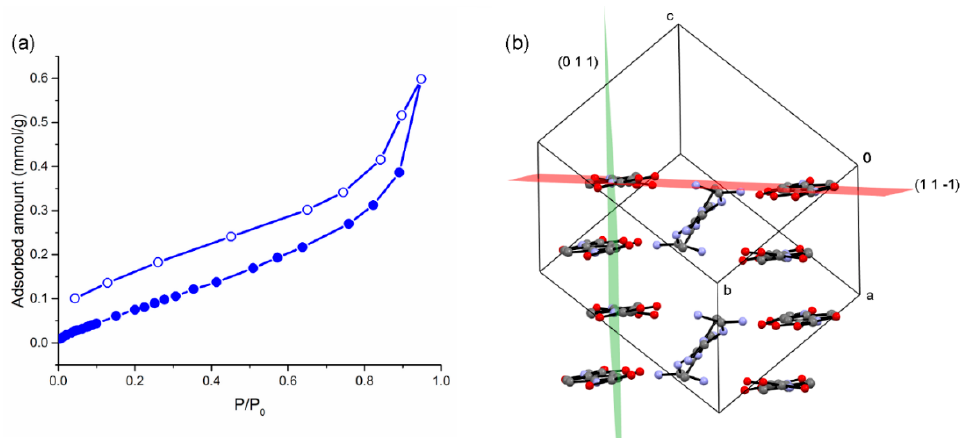
Figure 10. ( a ) Adsorption–desorption isotherm of H 2 Mf(HpOXA) 2 under nitrogen, solid circles for adsorption and hollow circles for desorption. ( b ) View of the H 2 Mf(HpOXA) 2 · 4W planes, water molecules are omitted. The hydrogen bonding network is weakened in the (1 1 − 1) family of planes by the loss of four water molecules, but hydrogen bonding and n → π * charge-assisted interactions prevail in the (0 1 1) family of planes.